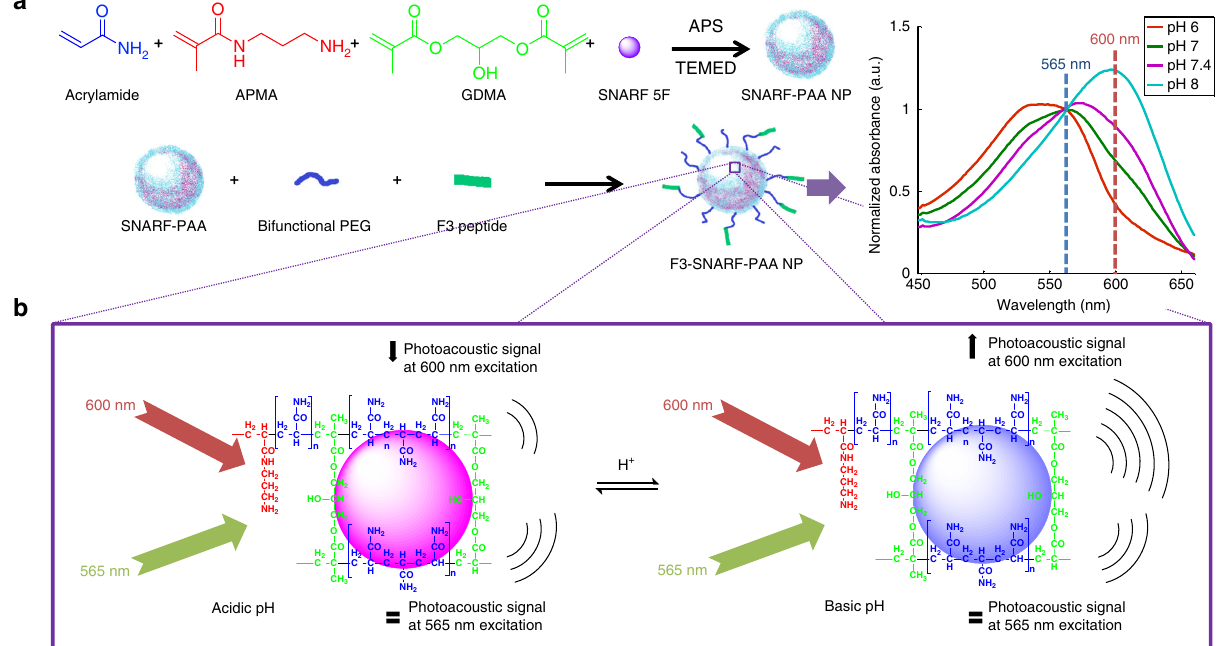
Fig. 1 SNARF-5F encapsulated polyacrylamide based nanoparticle (NP) synthesis and pH-sensing scheme. a Two-step synthesis schematic of SNARF-5F encapsulated acrylamide-based NP. The surface of the SNARF-PAA NP is modi fi ed with polyethylene glycol, for immune system avoidance, and with the tumor-homing F3 peptides. The normalized optical absorption spectra at different pH levels indicate the SNARF-PAA NP ’ s capability of pH sensing. The absorption at 565 nm, i.e., the isosbestic point, can be used as an internal reference point. The absorption at 600 nm can be used as a sensing point, which responds to difference in pH level. b PA pH-sensing scheme. The PA signal increases linearly with the optical absorption of NPs. Thus, the PA signal amplitude at 600 nm changes as the environmental pH changes; while the PA signal amplitude at 565 nm remains unchanged, acting as an internal reference